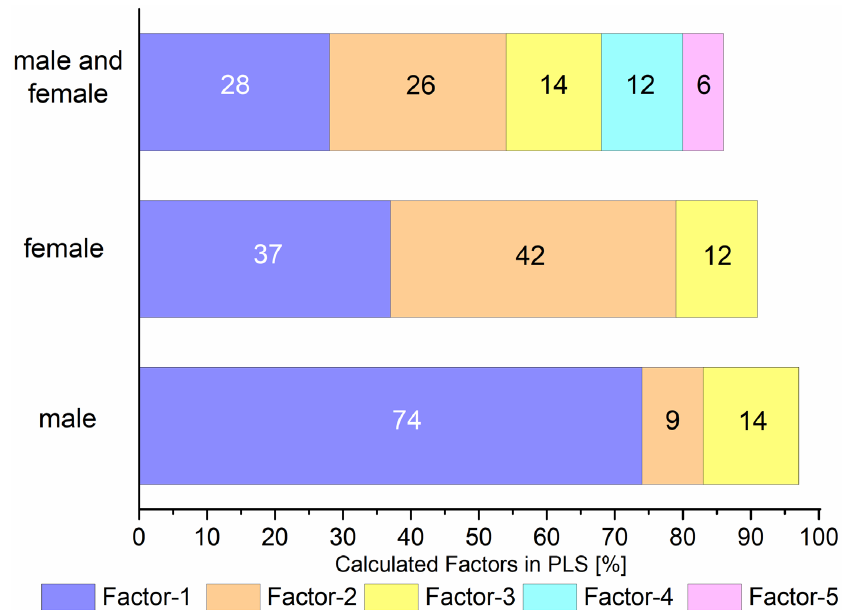
Figure 4. Comparisons of the first three (for male or female samples) and five PLS factors (for the entire population) in the distribution of data calculated for cancerous and non-cancerous samples. The total variance of each factor is presented on the bar in numbers.